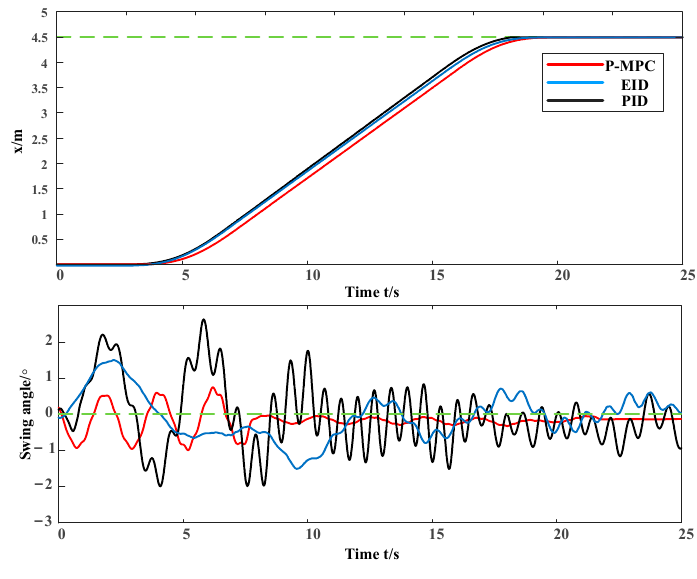
Figure 9. Result of Case 3. Table 3. The Comparison of the Three Approaches for Case 3.